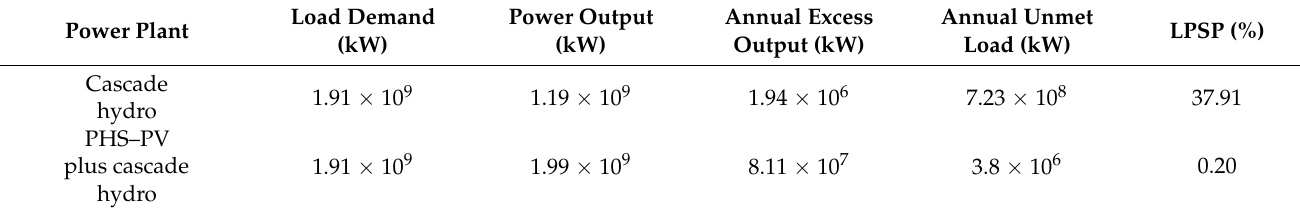
Table 6. Comparison of LPSP between cascade hydro and